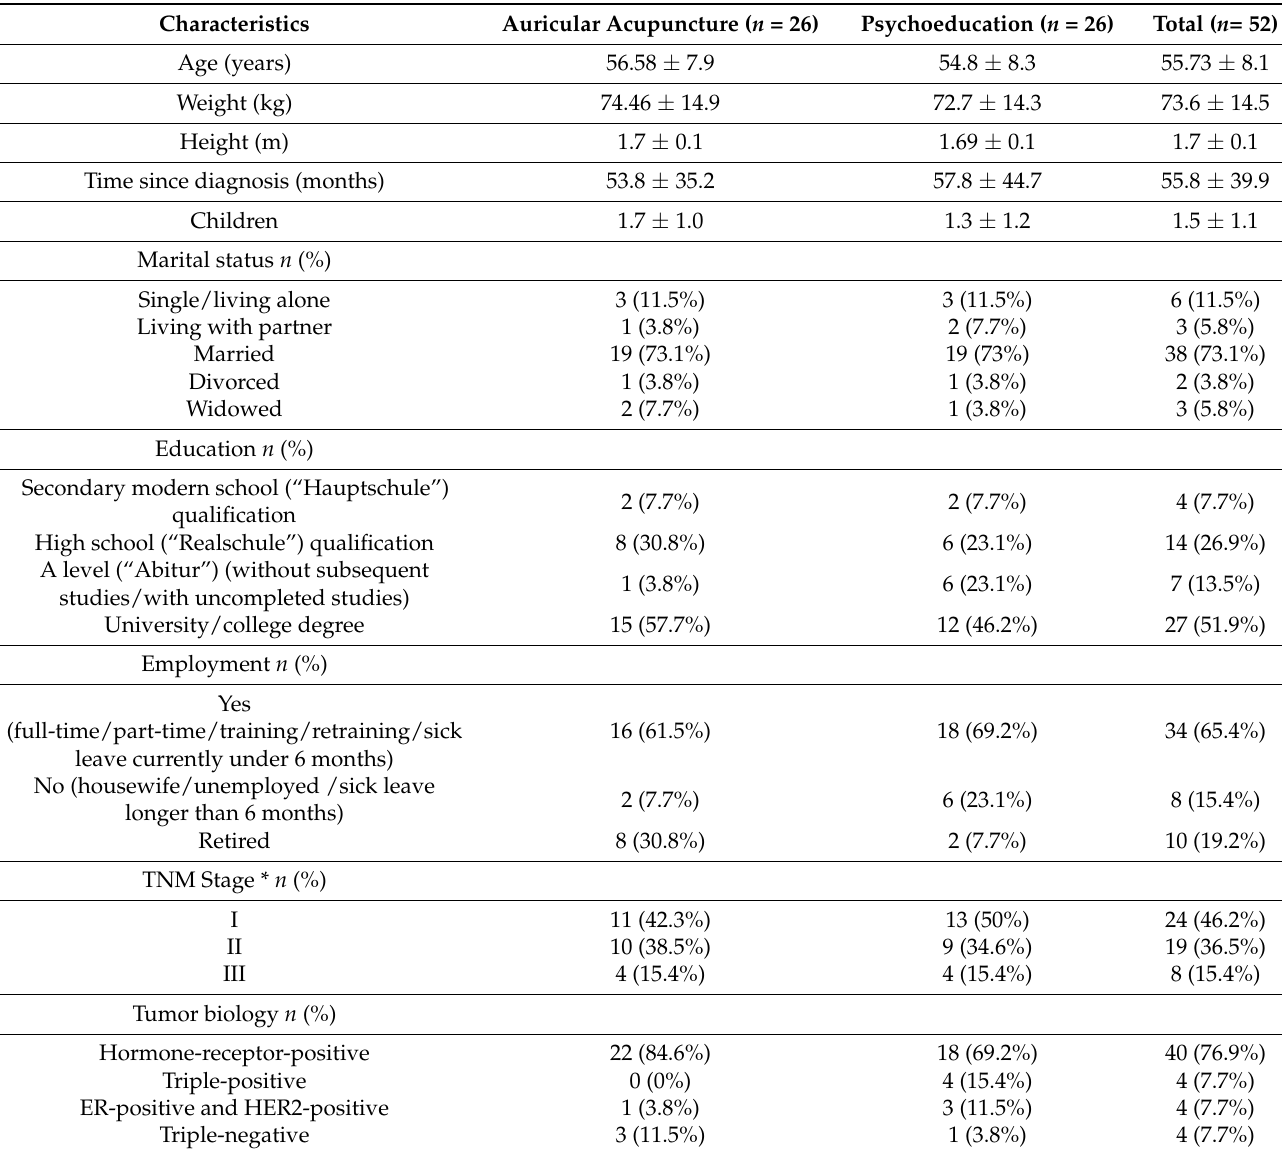
Table 2. Baseline sociodemographic and clinical characteristics. Values are expressed as mean ± standard deviation, unless indicated